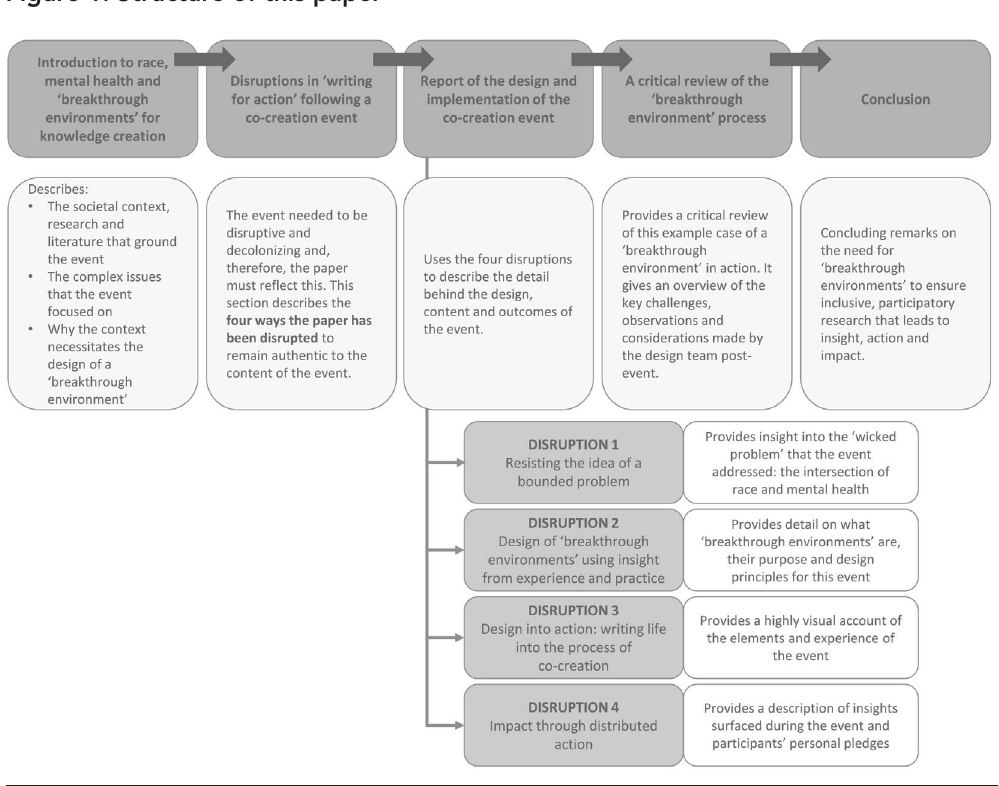
Figure 1: Structure of this